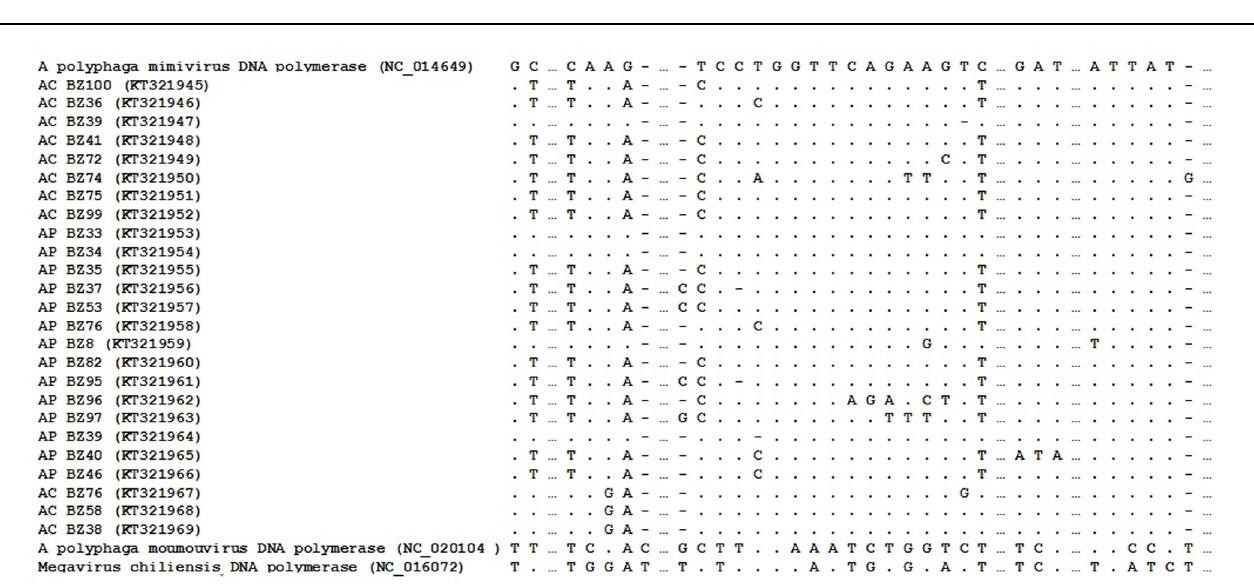
et al., 2014; Andrade et al., 2015; Assis et al., 2015).